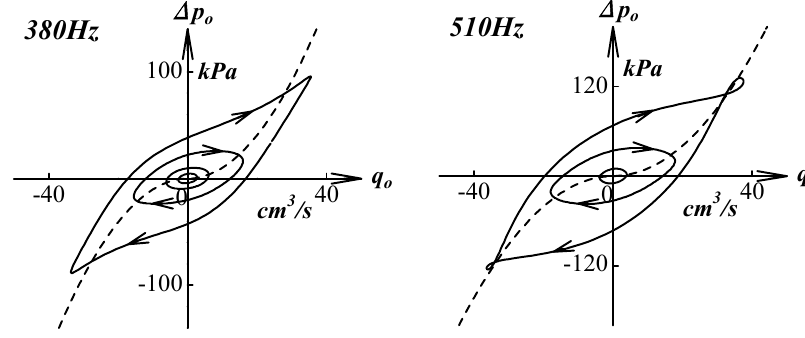
Fig.6 Unsteady relationship between pressure drop across and flow rate through orifice in a reciprocating oil